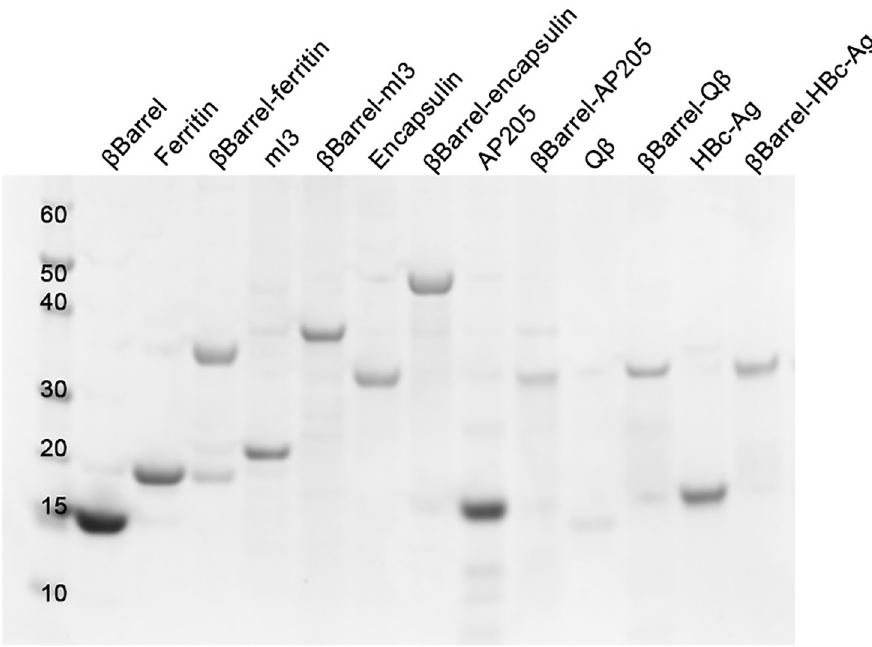
Fig 2. SDS-PAGE analysis of purified monomeric antigen, naked and chimeric NPs after SEC purification, performed under denaturing conditions and stained with Coomassie blue. First lane reports the molecular weight marker expressed in KDa. Theoretical molecular weights of each sample: β barrel 14KDa, Ferritin 21KDa, β barrel- Ferritin 34,8KDa, mI3 23,6 KDa, β barrel-mI3 37,3KDa, encapsulin 32,1 KDa, β barrel-encapsulin 45,9 KDa, CP3 15,2 KDa, β barrel-CP3 29,5KDa, Q β 16,1 KDa, β barrel-Q β 29,7KDa, HBcAg 19KDa, β barrel-HBcAg 32,3 KDa.